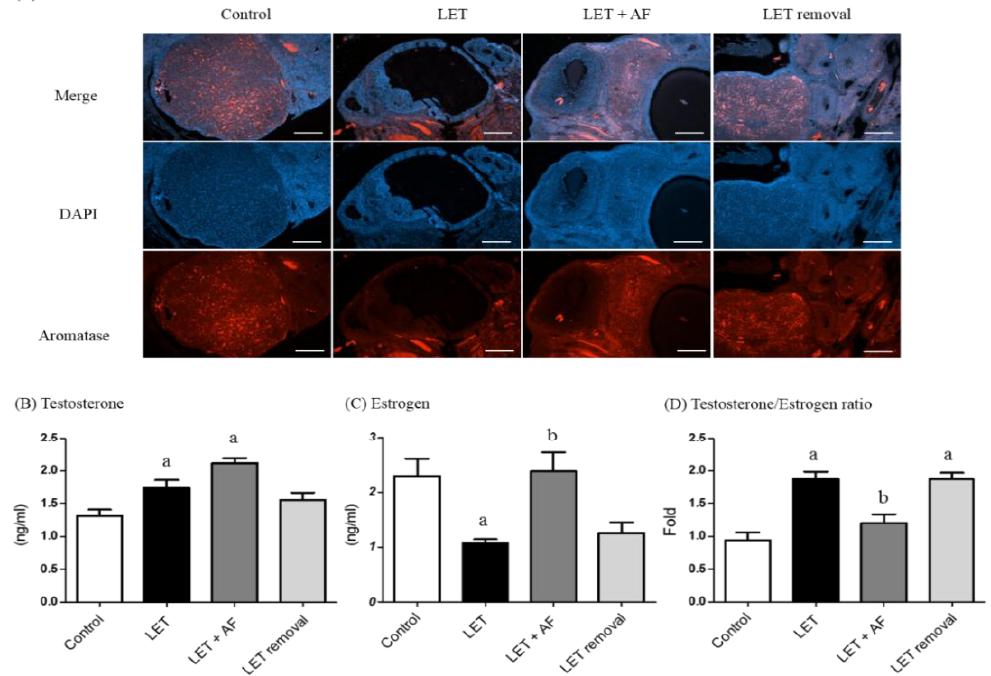
Figure 7. Effect of A. fistulosum root extract on ovarian aromatase localization and expression in letrozole-induced PCOS rats. Section of ovary was performed by immunohistochemistry using specific ( A ) aromatase antibody; the 2nd Ab was rabbit (Scale bar = 400 µ M), counterstained with DAPI. ( B ) Testosterone and ( C ) estrogen were measured using a competitive enzyme-linked immunosorbent assay (ELISA) kit. ( D ) Testosterone and estrogen ratio. Values represent means ± SEM; n = 5–10 per group; a p < 0.05 vs. Control group b p < 0.05 vs. LET group. AF: A. fistulosum , LET: letrozole .